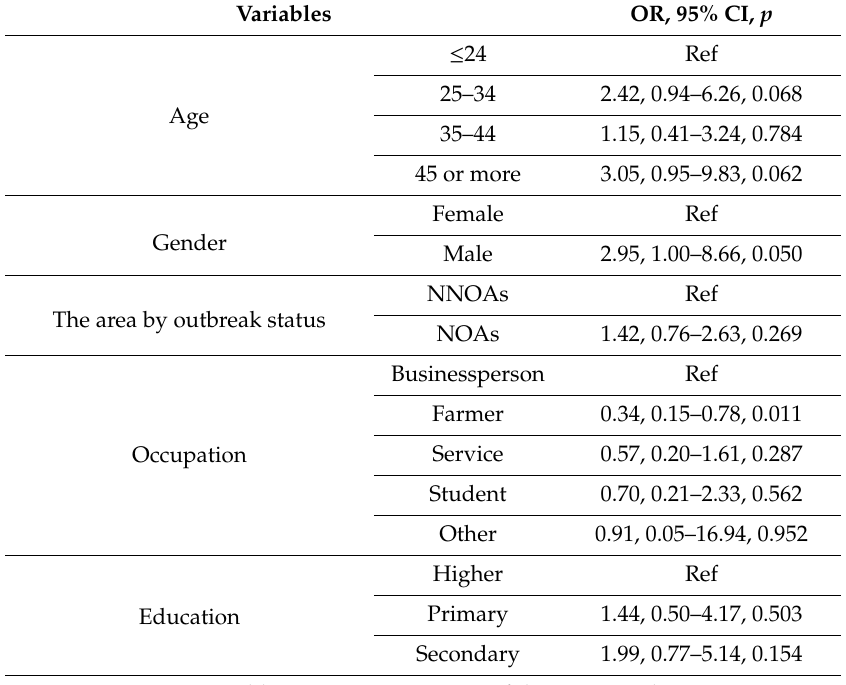
Table 4. Logistic regression analysis of the factors associated with respondents’ knowledge, attitudes, and perceptions of the ecology and myths of